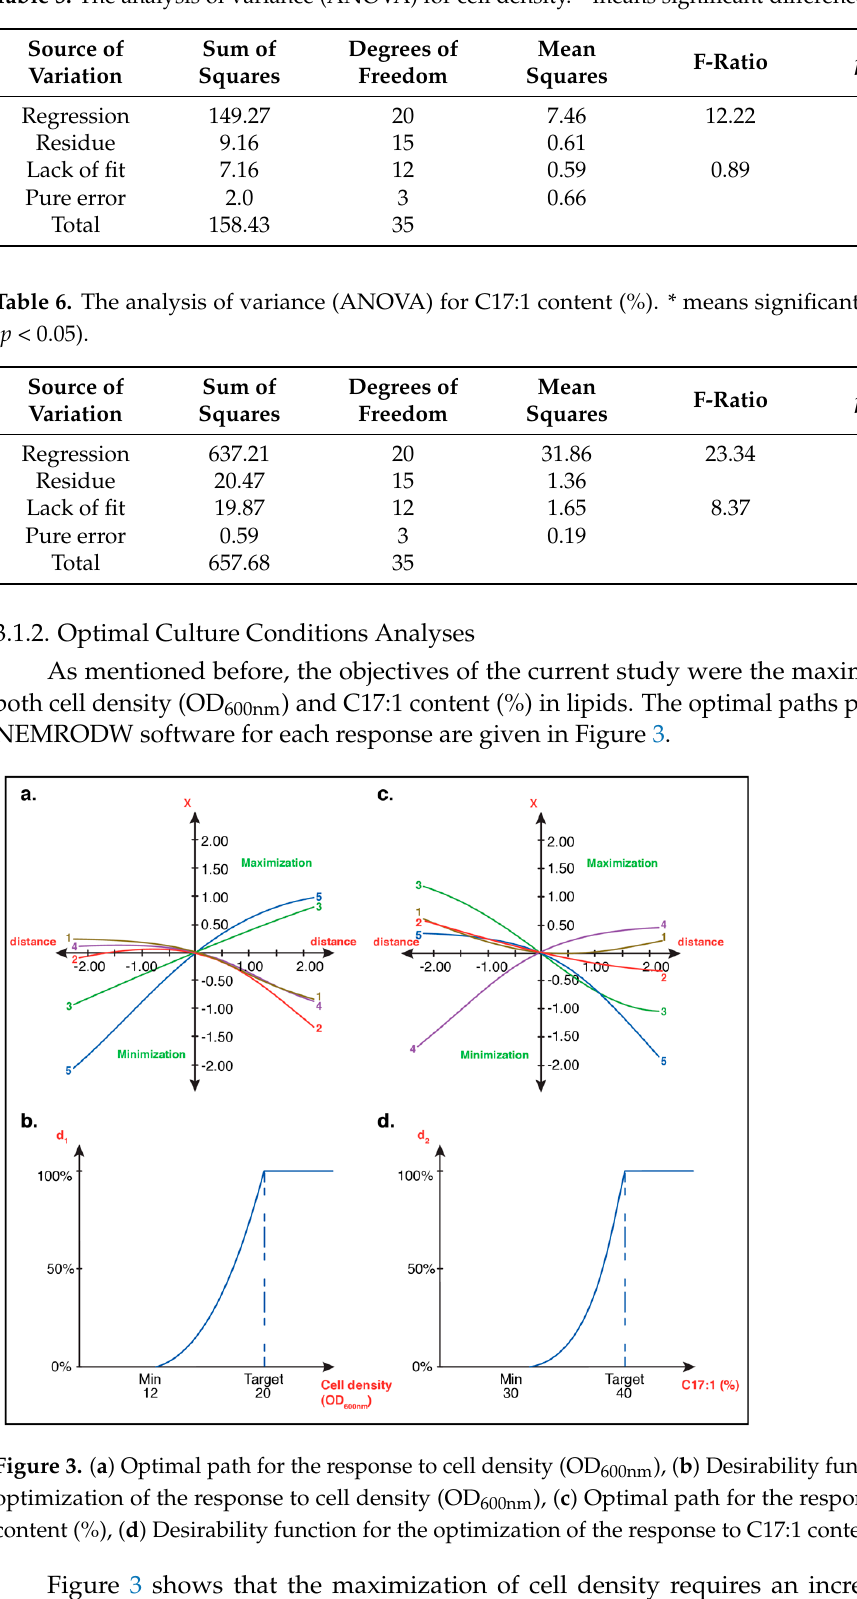
Table 5. The analysis of variance (ANOVA) for cell density. * means significant differences ( p < 0.05).